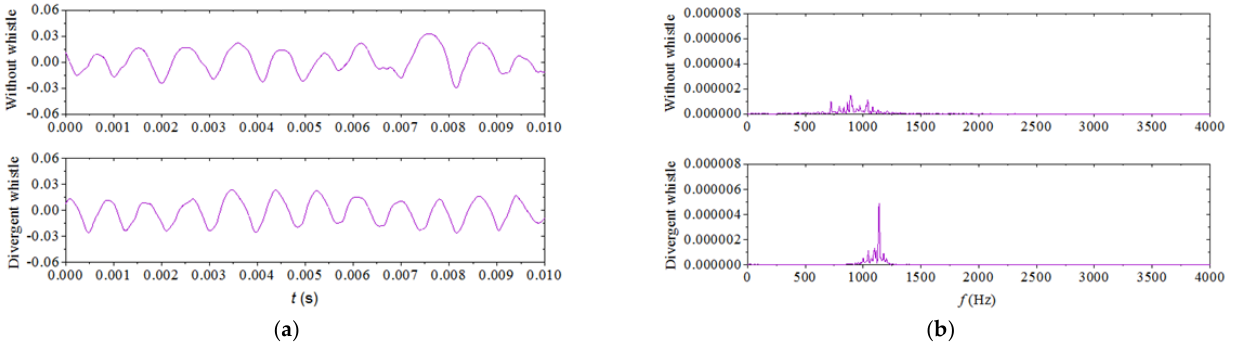
Figure 9. Time- and frequency-domain plots of cavitation cloud by nozzles with different outlet shapes. ( a ) Time-domain plot. ( b ) Frequency-domain